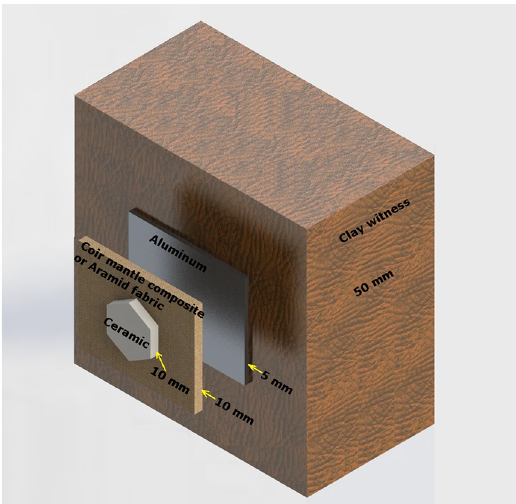
Figure 2. Schematic of the MAS placed in front of a block of clay witness simulating a human body. Composite plates with lateral sides of 120x150 mm